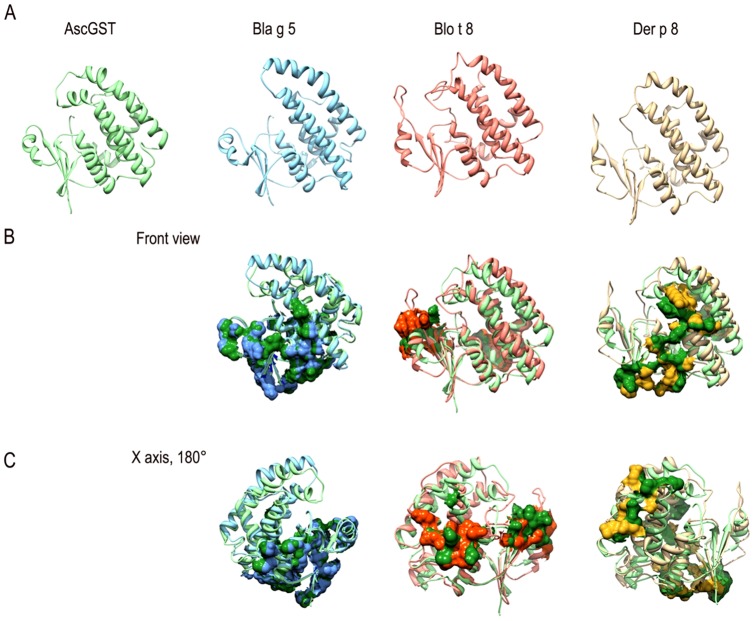
Predicted tertiary structures of Ascaris and non-parasitic GSTs.(A) Ribbon representations of the predicted structures of Ascaris GST1, cockroach GST (Bla g 5) and house dust mite GSTs (Der p 8 and Blo t 8). (B) Superposition of A. suum GST1 with Bla g 5, Blo t 8 and Der p 8. Patches of solvent-accessible and conserved residues are shown in surface view. (C) 180° rotation (Y axis) of all structures to visualize other conserved regions.